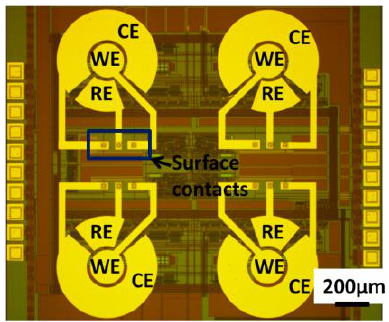
Figure 17. A 2 × 2 thin film planar gold microelectrode array fabricated on a CMOS chip, which includes WE, CE and